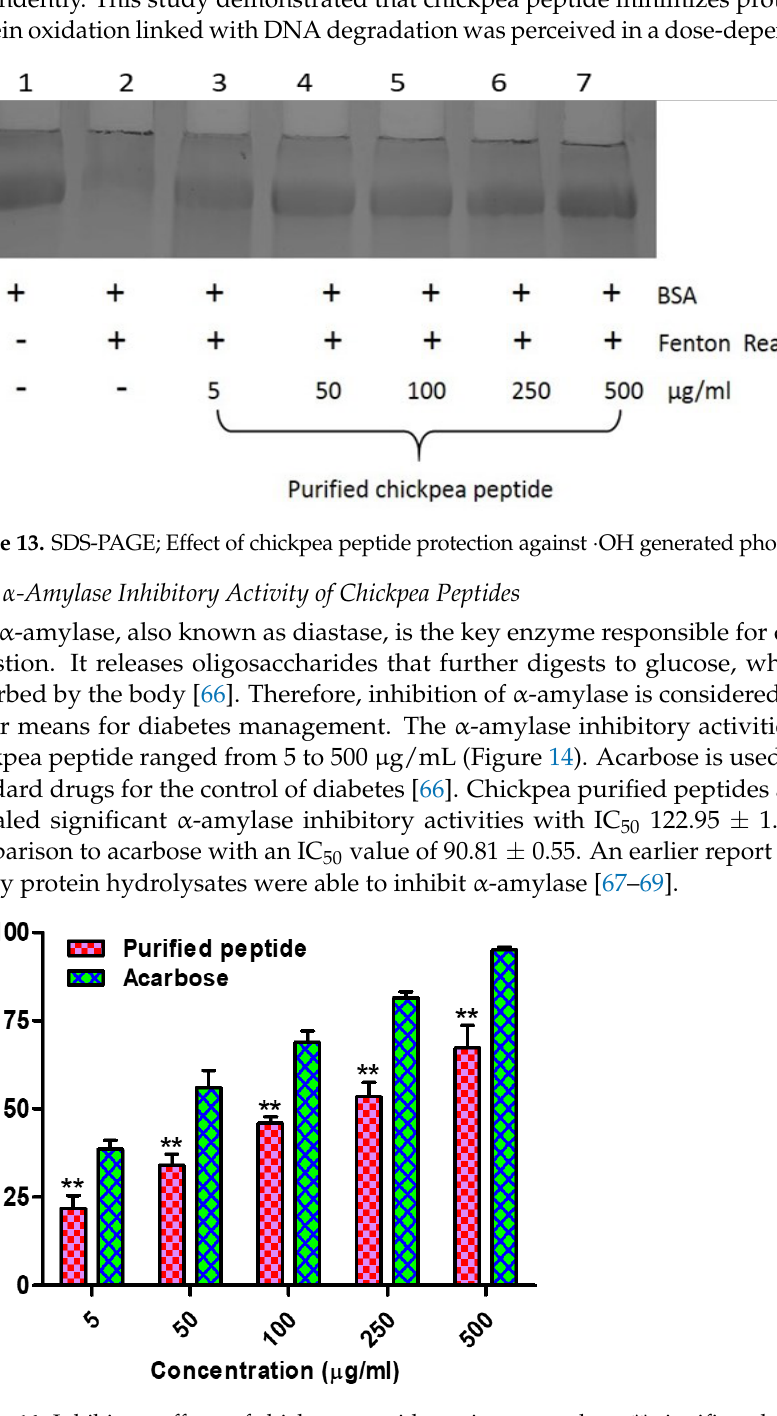
dependently. This study demonstrated that chickpea peptide minimizes protein oxidation.